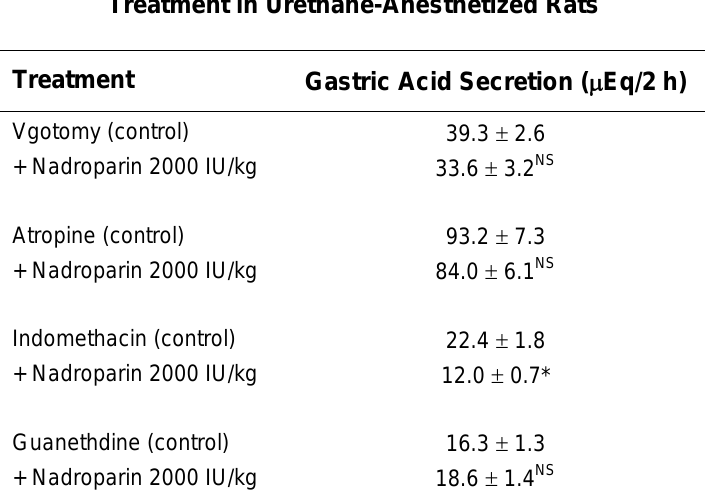
Effect of Nadroparin on Distention Plus Histamine-Induced (5 mg/kg, i.p.) Stimulation of Gastric Acid Secretion after Subdiaphragmatic Vagotomy, Atropine (1 mg/kg, i.p.), Indomethacin (20 mg/kg, i.p.), or Guanethdine (8 mg/kg, i.p.) Treatment in Urethane-Anesthetized Rats